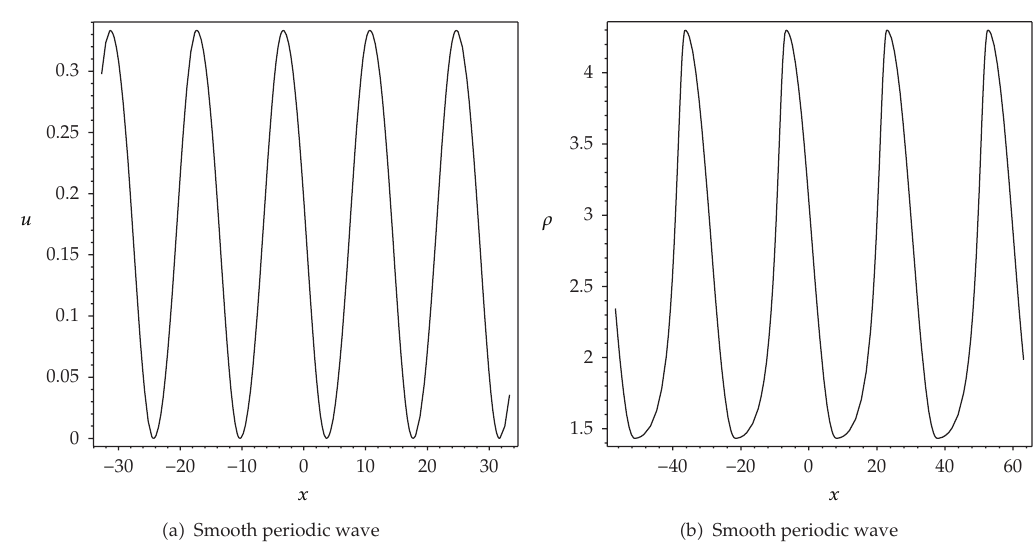
Figure 5: The profiles of smooth periodic waves of solutions (cid:2) 3.20 (cid:3) for the given parameters: (cid:13) (cid:7) 1 , σ (cid:7) − 1 , κ (cid:7) − 4 , v (cid:7) 3 , δ (cid:7) 5 , t (cid:7) 1 and di ff erent ε -values: (cid:2) a (cid:3) ε (cid:7) − 0 . 2; (cid:2) b (cid:3) ε (cid:7) − 2.